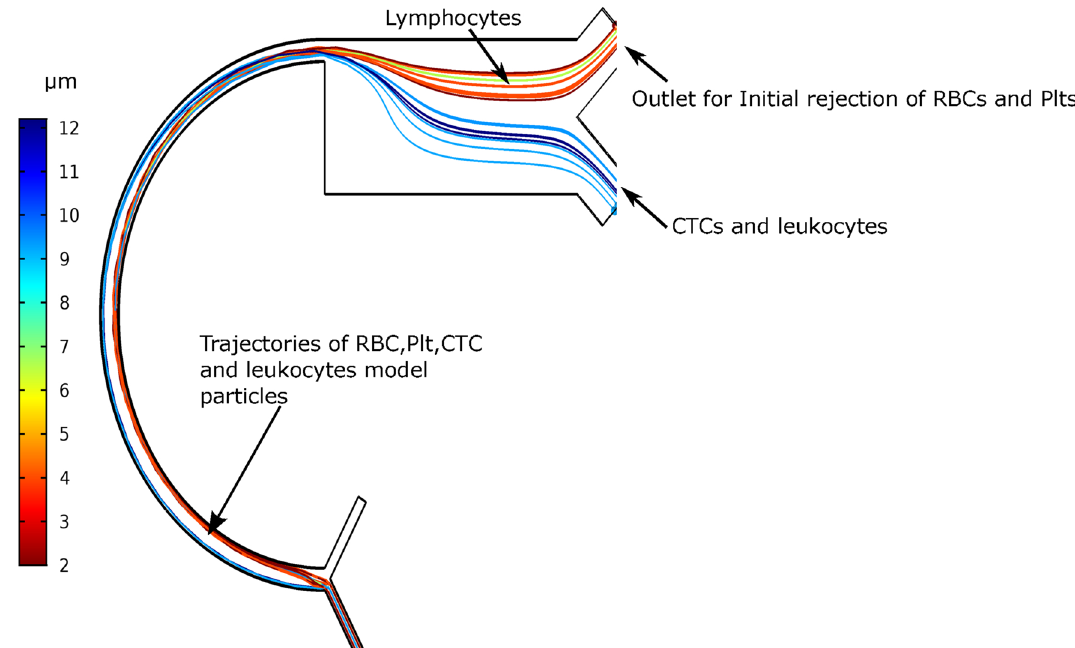
Figure 8. Results of the particle tracing of whole blood sample while considering subtypes of leukocytes. The color legend shows sizes of particles being injected. In the expansion region separation of small particles i.e., RBC and Platelets takes places from the larger particles i.e., CTCs and WBCs and they continue to move towards their respective outlets. However, it has been observed that certain subtypes of WBCs made their way along with RBCs and Plts towards the waste outlet for the initial rejection of RBCs and